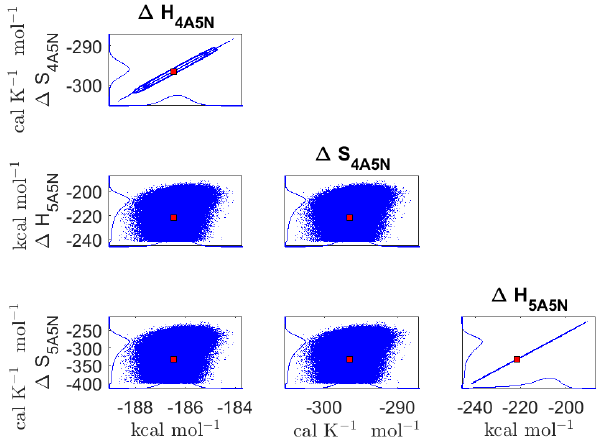
Figure D5. Pairwise marginal posterior distributions (for param- eter indexes ranging from 25 to 28) of the cluster formation en- thalpies and entropies determined from steady-state cluster con- centration measurements at two temperatures ( T = 278K and T = 292K). Red rectangles denote the baseline values from Olenius et al. (2013b) used to generate the synthetic data. Here, the symbols (cid:49) H and (cid:49) S stand for cluster formation enthalpies and entropies, re- spectively. The notation xAyN corresponds to a cluster with x sul- furic acid and y ammonia